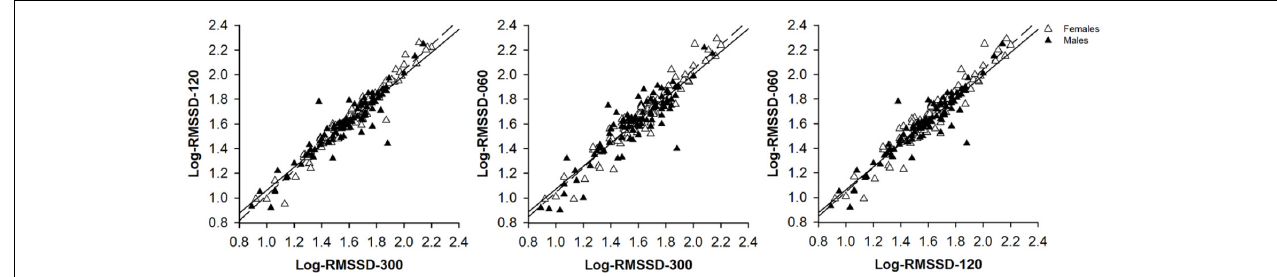
FIGURE 2 | Scatter plots with lines of best fit demonstrating bivariate correlations between (log-transformed) vagally mediated heartrate variability (Log-RMSSD) that was derived from 300 s (Log-RMSSD-300), 120 s (Log-RMSSD-120), or 60 s (Log-RMSSD-060) lasting resting state recordings of male (black triangulars, solid line) and female (white triangulars, dashed line) participants’ heart